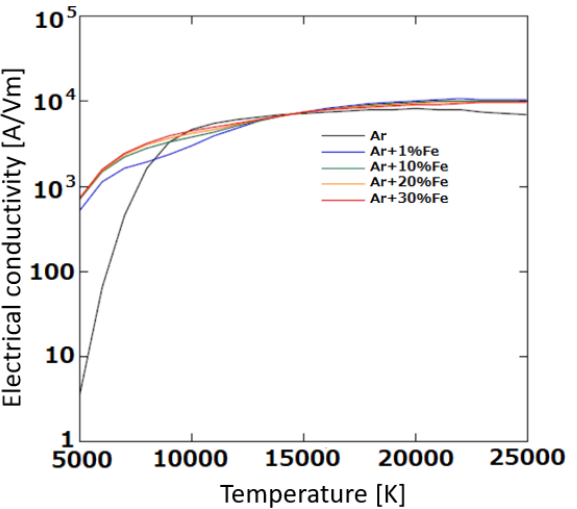
Figure 7. Dependence of electrical conductivity on temperature and metal vapor concentration.